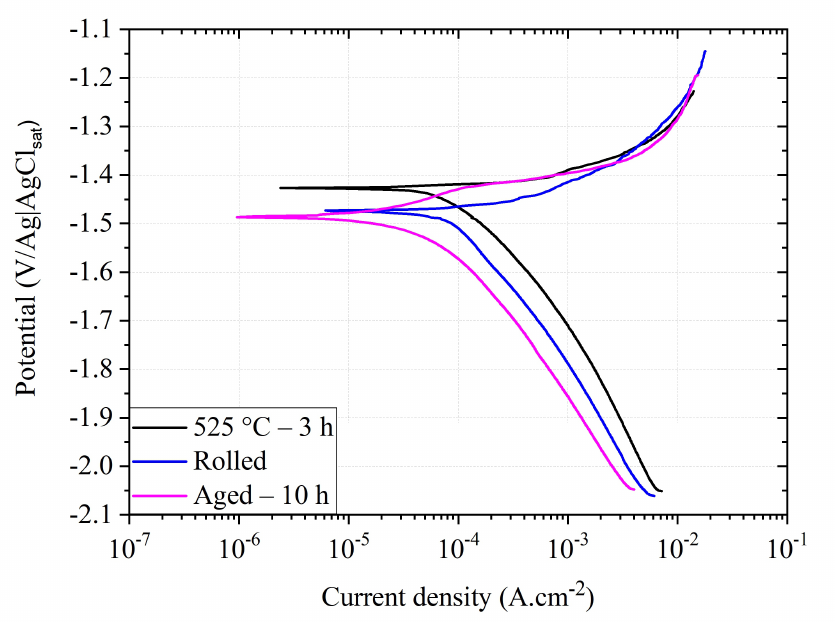
Figure 6. Open circuit potential curves of H525 ◦ C-3 h, rolled and aged-10 h specimens in 0.9 wt.% NaCl aqueous solution at 37.0 ± 0.5 ◦ C.